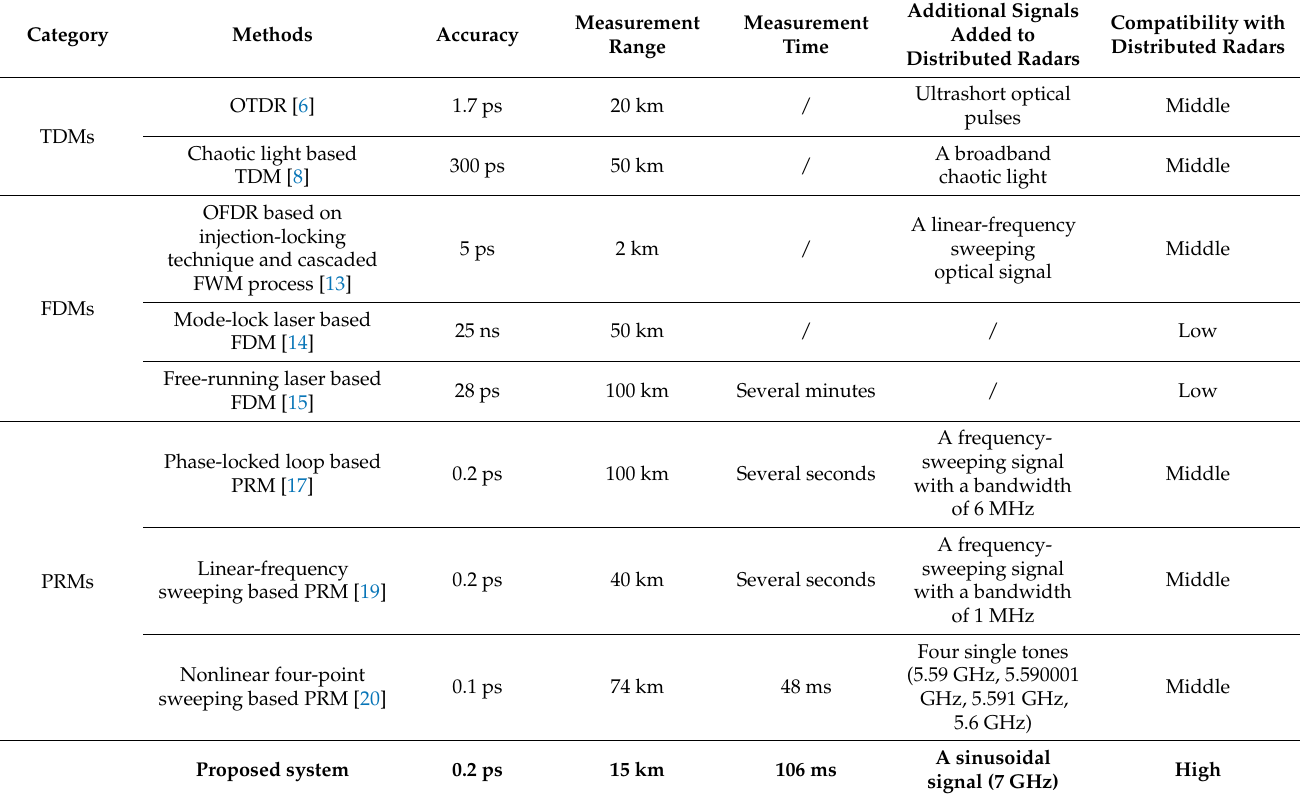
Table 2. Comparison of the Measurement